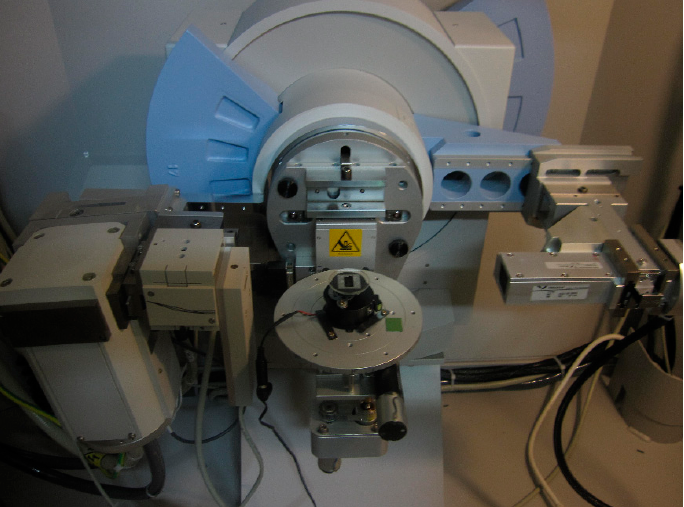
Materials 2021 , 14 , 832